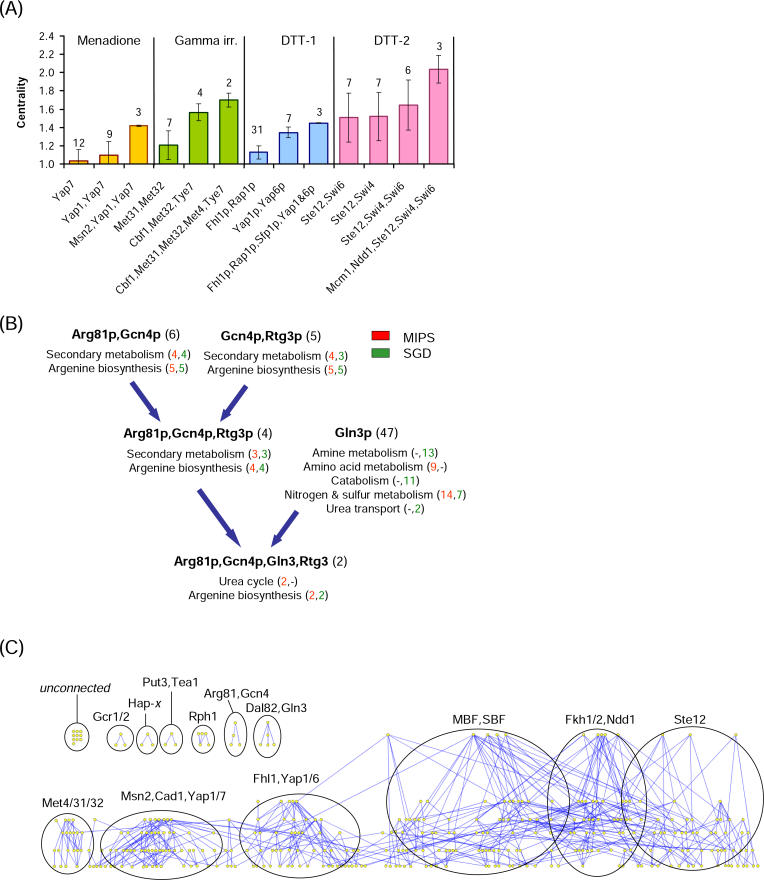
Combinatorial Regulation by TF Modules(A) Bars show average centrality (see Materials and Methods) of target genes overlapping with stress-related clusters (± standard error). Values above bars are numbers of overlapping target genes. Generic TFs such as Yap1p or Swi6p are reused in several modules. Combination with other TFs yields specificity (i.e., a smaller number of target genes and an increased centrality).(B) Hierarchy of TF modules. Arrows represent a subset relationship (i.e., all TFs of the source module are contained in the target module). Downstream TF modules always share their targets with upstream TF modules. Annotations are based on significant (p < 10−4, hypergeometric distribution) overlaps between the target gene sets and the respective functional category. Values in parentheses are numbers of target genes (black) and numbers of overlapping genes (red, green).(C) Complete hierarchy of the 363 significant TF modules (p
mod < 10−4). Highlighted regions contain TF modules that are enriched with the respective TFs or TF complexes.